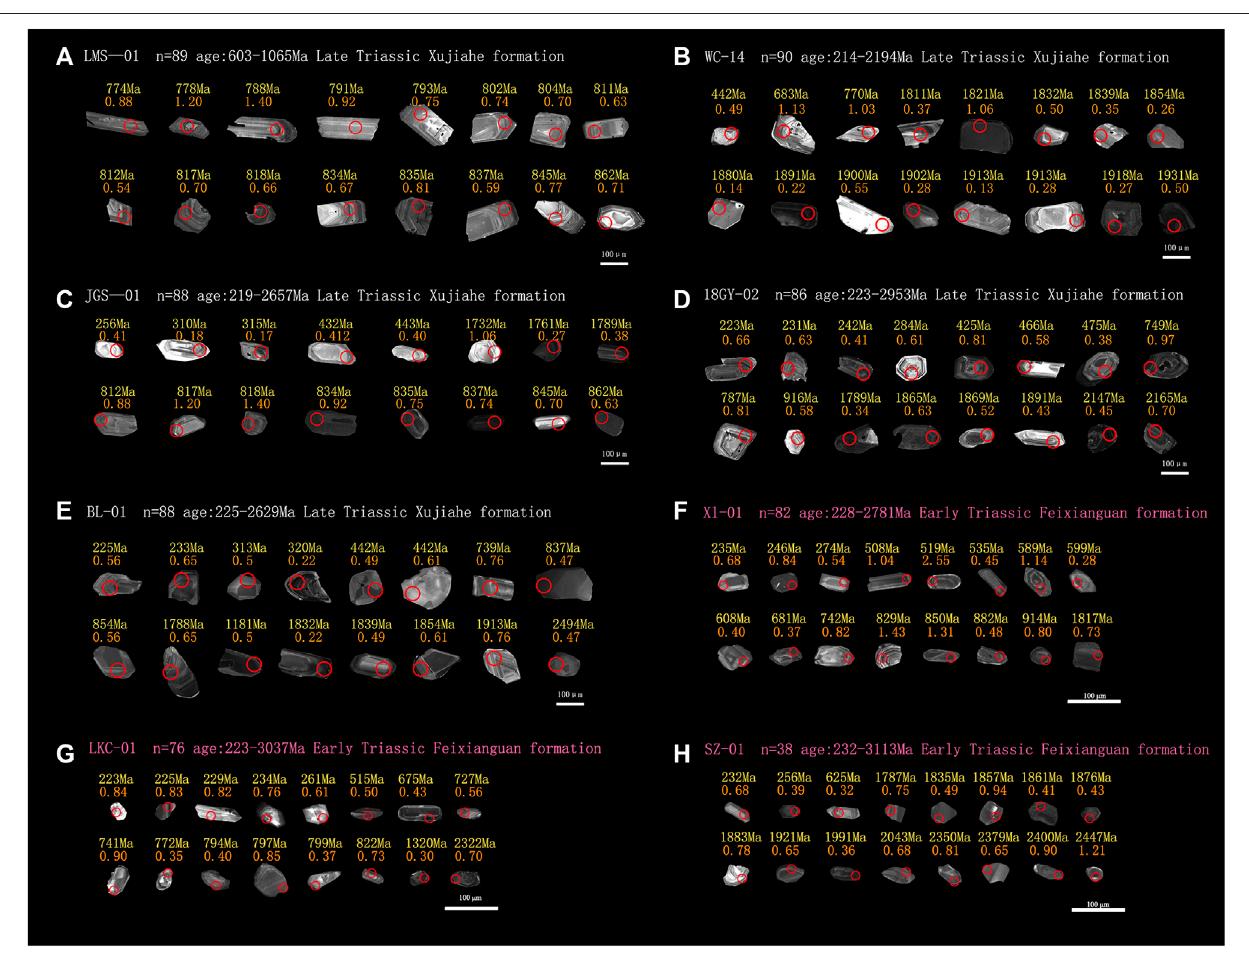
FIGURE 7 | Representative cathodoluminescence (CL) images from samples of Late Triassic formation (A – E) and samples of Lower Triassic formation (F – H) showing the internal structure, texture, and morphology of zircon grains. The red circles represent the sites of U – Pb age analysis. The yellow fi gures and orange fi gures represent the measured ages and the ratio of Th/U,